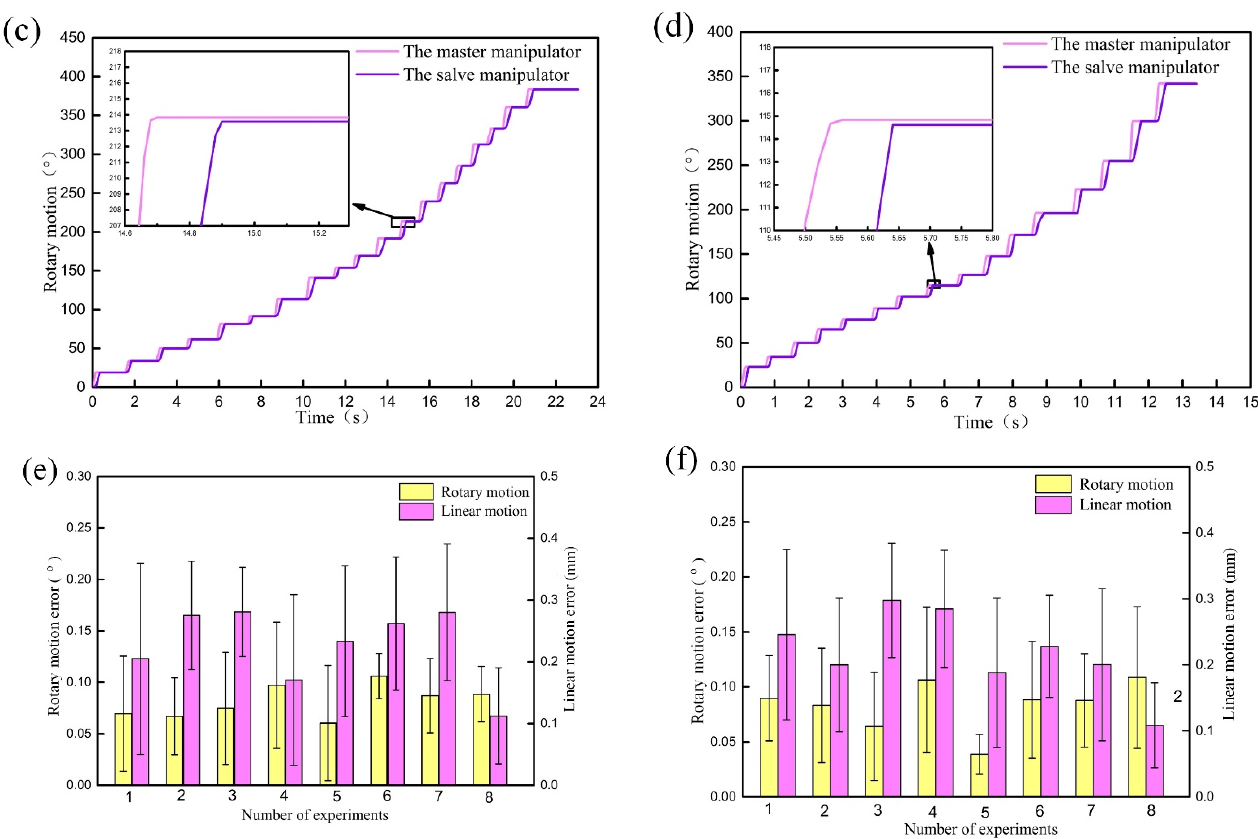
Figure 10. Linear tracking trajectory, rotary tracking trajectory, and tracking errors of the GM ( a , c , e ) and CM ( b , d , f ).